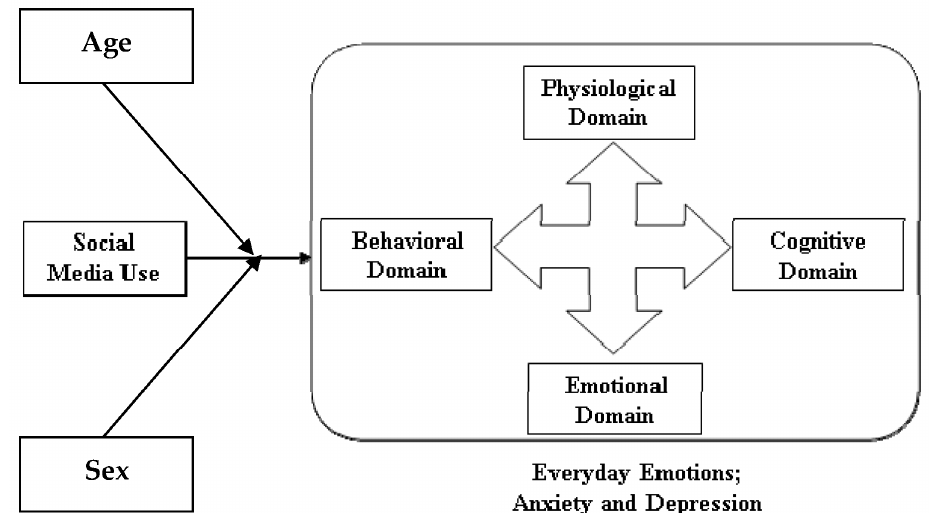
Figure 1. Model of SMU-EE.